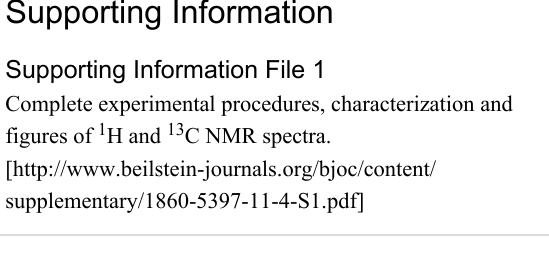
displayed growth inhibitory activity against Bacillus subtilis in a preliminary